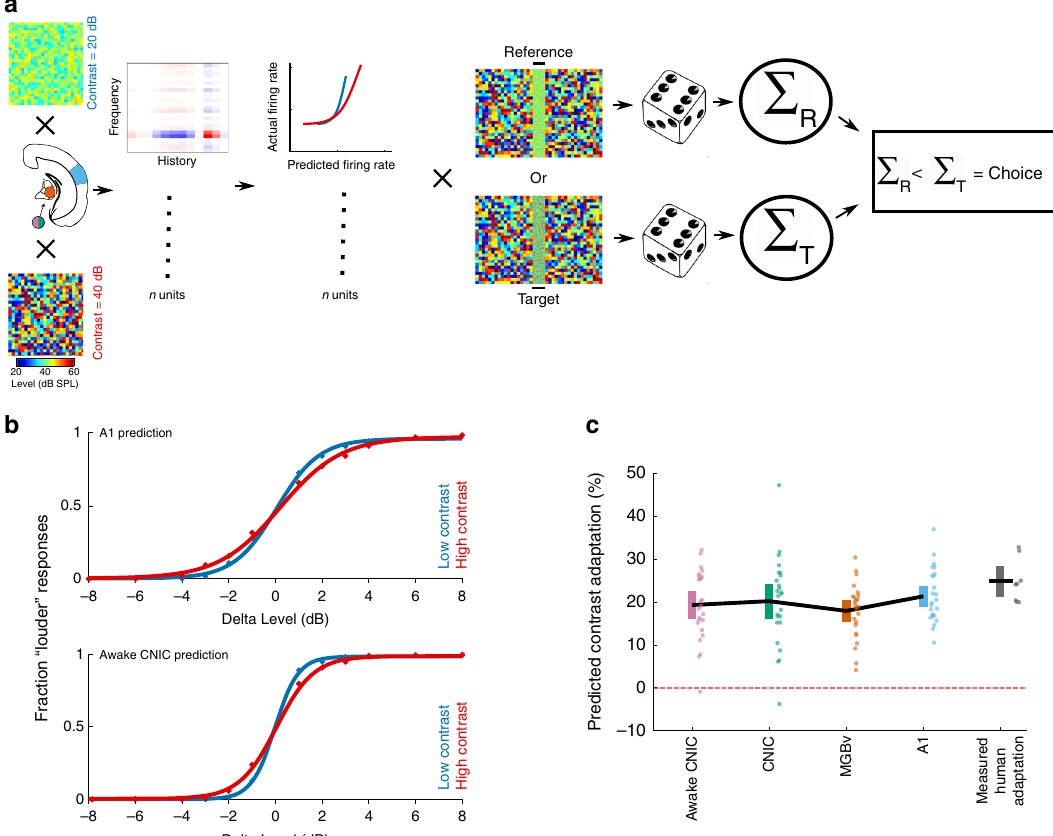
Fig. 7 The strength of perceptual contrast adaptation can be predicted from contrast adaptation in auditory neurons. a Schematic of model that uses the neuronal responses to predict performance on a 2-AFC sound level discrimination task (100 ms broadband noise in different contrast environments; see Methods). b Psychometric functions produced by the model from A1 units (top) or awake CNIC units (bottom) in low- (20 dB, blue) and high- (40 dB, red) contrast conditions. c Predicted strength of contrast adaptation from units recorded in awake CNIC or in CNIC, MGBv, or A1 under anesthesia, compared with measured perceptual contrast adaptation in human listeners. Solid black lines connect mean values after 25 runs of the model (or across the eight participants in the measured human adaptation). Colored error bars denote 95% con fi dence intervals around the mean (individual data points are displayed next to the corresponding error bars). Source data for c are provided as a Source Data fi